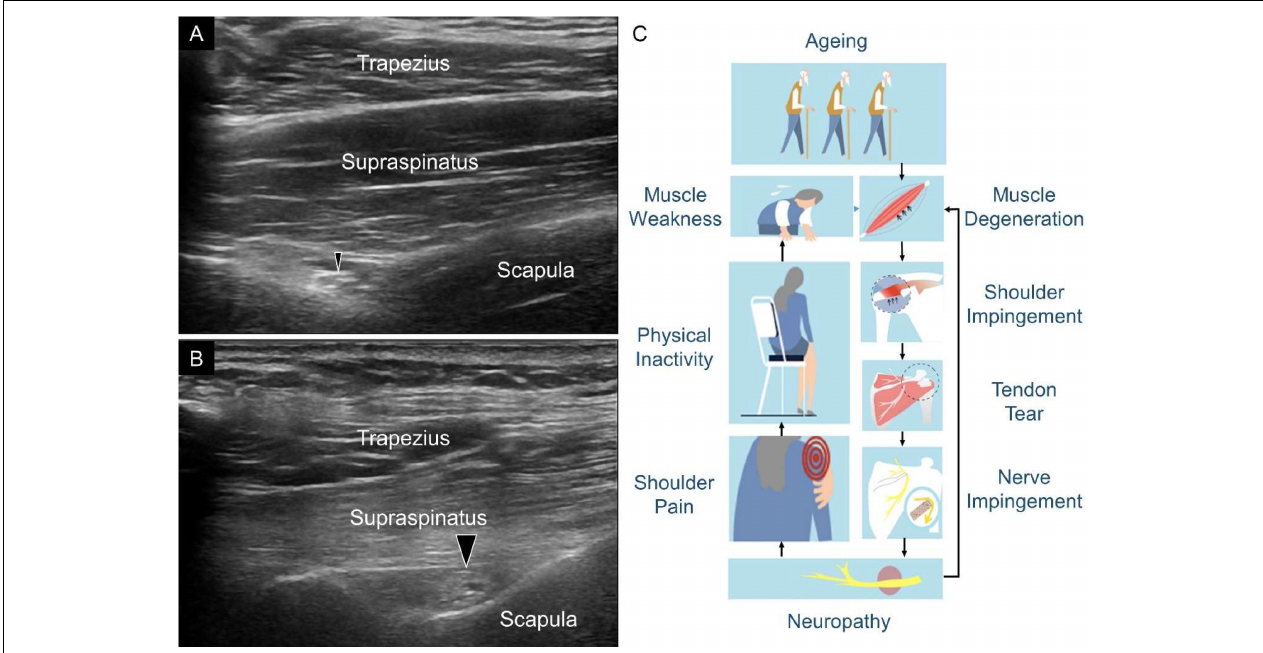
FIGURE 4 | Ultrasound imaging of the suprascapular nerve (SSN) (black arrowheads) in one shoulder without supraspinatus tendon full-thickness tear (A) and the contralateral shoulder with supraspinatus full-thickness tear (B) . Atrophy of the supraspinatus muscle and enlargement of the SSN with thickened epineurium were seen in the shoulder with supraspinatus tendon full-thickness tear. A plausible flow diagram demonstrates how rotator cuff tendon tears interplay with SSN abnormalities in the aging population (C) .